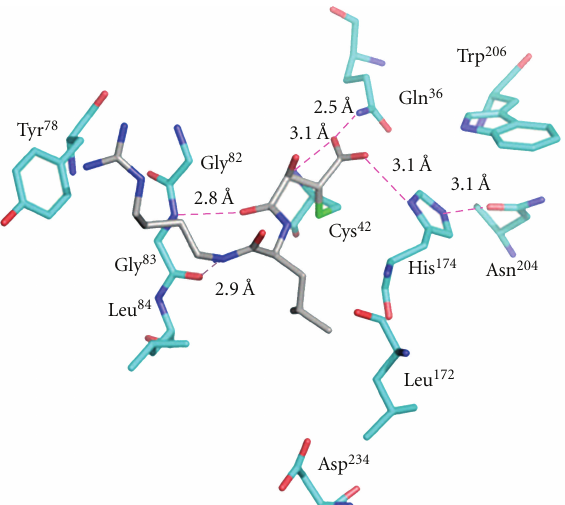
Figure 10: Interaction between falcipain 3-leupeptin: the residues in the active site of falcipain-3 are colored yellow and labeled, and leupeptin is colored in gray. The interactions with enzyme and inhibitor are in pink